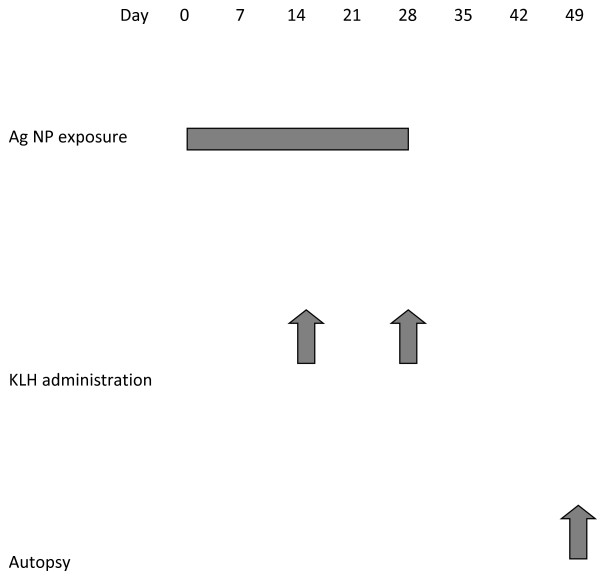
Experimental design.